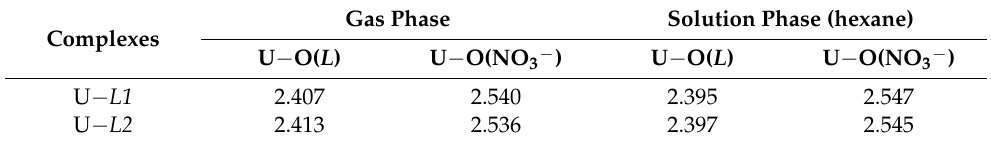
Table 2. Average bond lengths(Å) of two complexes after extraction in both gas phase and solution phase.